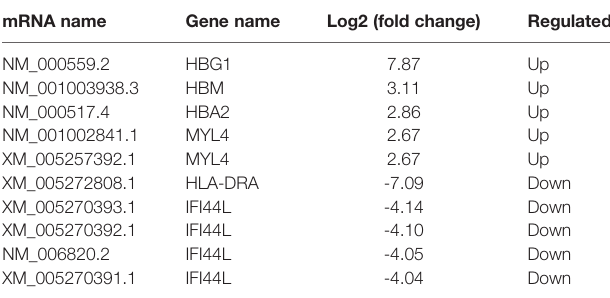
TABLE 3 | The top 5 differentially expressed mRNAs.